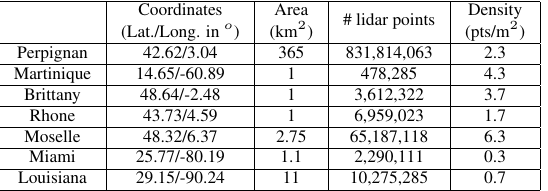
Table 1: Description of the areas of interest. Miami and Louisiana datasets have been provided by the NSF through the OpenTopog- raphy portal (NSF, 2012) and acquired with Leica ALS50 and ALS40 respectively. Other datasets have been acquired by the French Mapping Agency using an Optech 3100EA device.